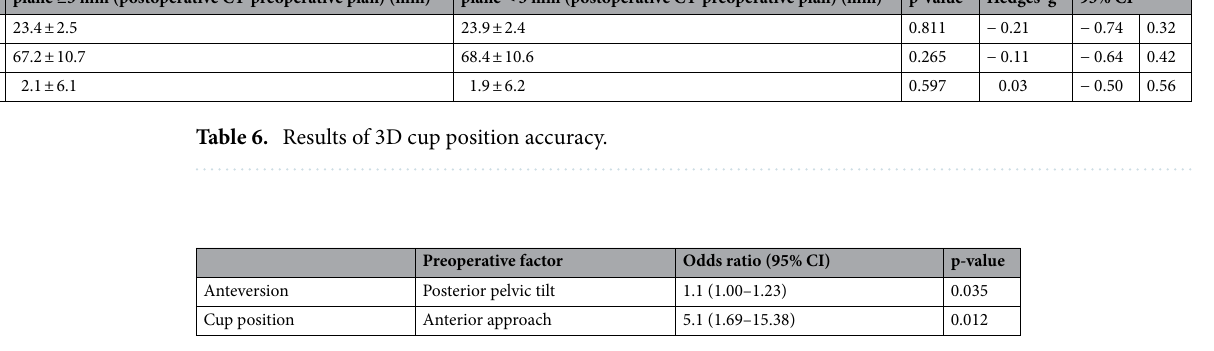
Table 7. Results of the multivariate analysis for preoperative factors for inaccurate cup positioning of robotic- assisted